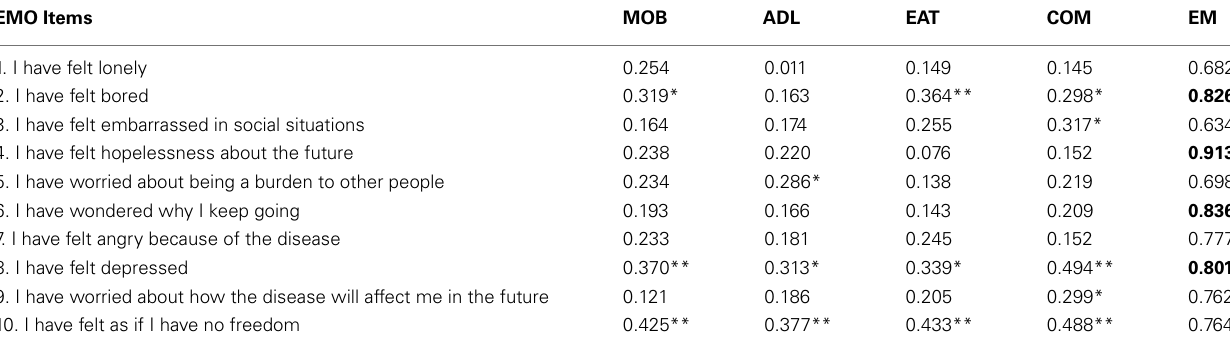
Table 9 | Correlations between EM items and other areas at the third